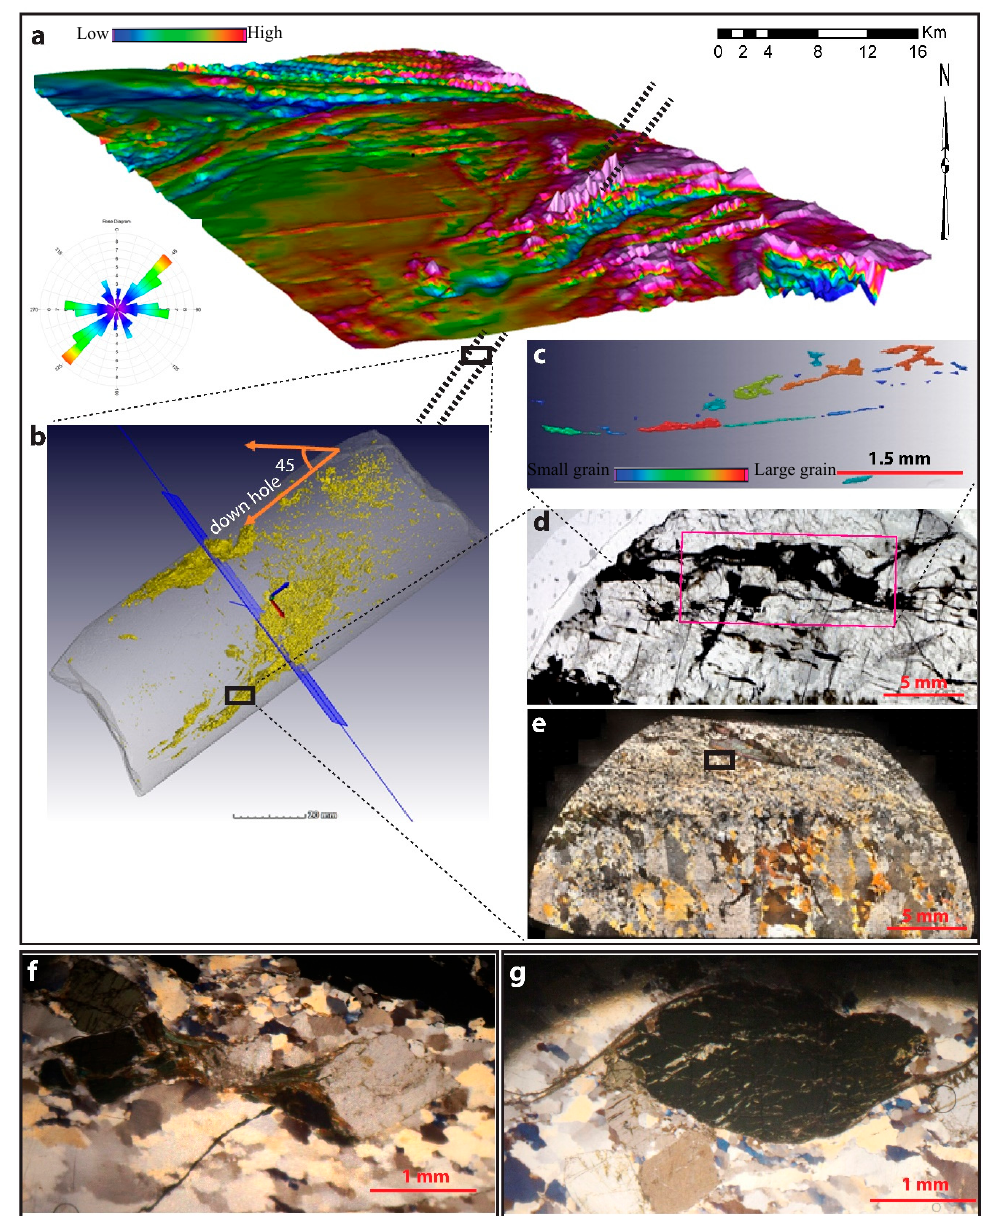
Figure 9. Nature of gold mineralization. ( a ) Structures (faults, fractures, shear zones and dykes) that were derived from interpretation of airborne magnetic data. The magnetic data show prominent lineaments that represent faults and shear zones. The faults and fractures and shear zones are thought to have acted as conduits for mineralizing hydrothermal fluids. Rose diagram show the dominant trend of structures to be NE–SW. ( b ) Drill core drilled from the indicated hole show that the mineralized vein system and the sulphide distribution also show the same trend; the distribution of the sulphides show that the sulphide minerals occur as an interconnected subvertical network and have preferred orientation. The orientation of sulphides is consistent with dominant structures in the field. The grey colour is the silicate matrix and the yellow colour indicates sulphides. ( c ) XCT scanned image of the thin section made from indicated rectangle shows gold grains have been elongated / stretched in this dominant NE orientation along the shear plane, (warm colours = large gold grains, cold colours = smaller gold grains). ( d , e ) Milled grains and stretched minerals in thin section from the drill core cut along the rectangle indicated on the drill core indicating shearing. ( f , g ) Shear sense indicators observed from thin section e above on the shear plane using a 50 × objective lens. Sample